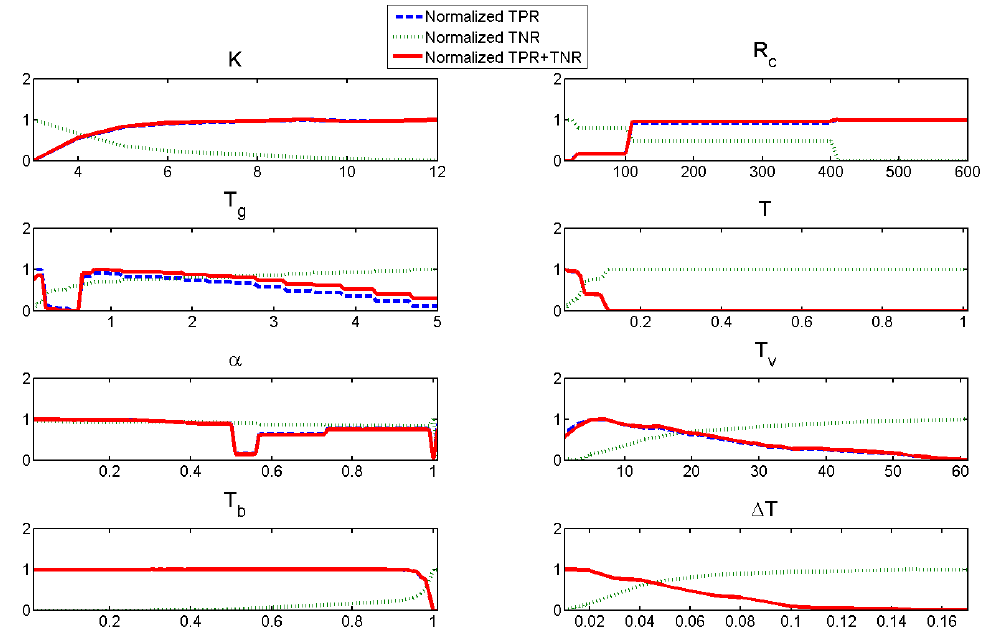
Figure 14. Normalized TPR, TNR and TPR + TNR of each parameter of the proposed background subtraction method for the ArtiumLassonde video. Untested parameters were kept fixed.